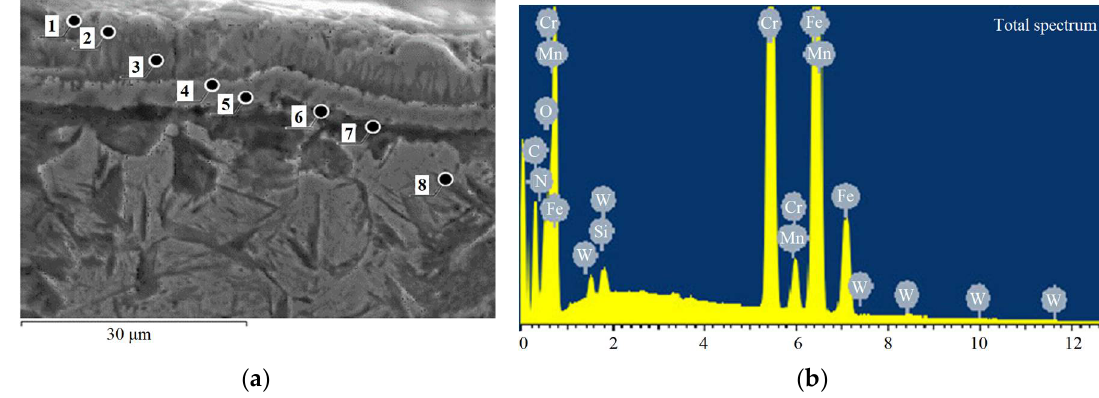
Figure 5. Microstructure ( a ) and spectrum ( b ) for steel DIN 105WCr6 after nitrogenchroming: nitriding (temperature— 540 °C, time—36 h) and chroming (temperature—1050 °C, time—4 h), Cu emission K α of 0.154 nm.